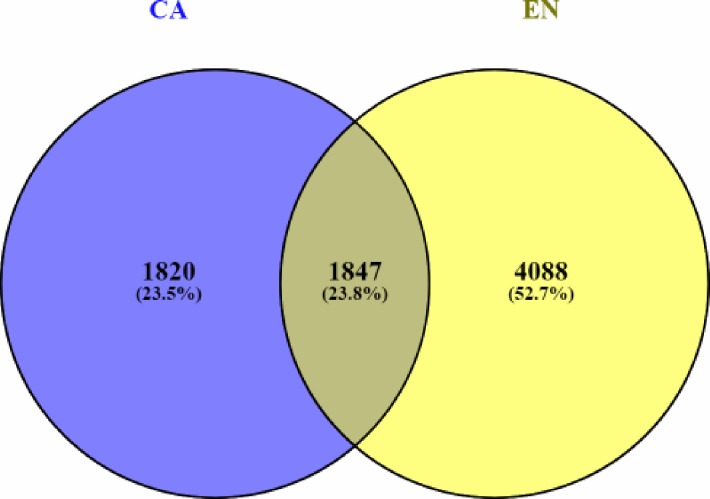
Venn diagram of differentially expressed genes.Graphical representation of the overlap of differentially expressed genes by group (FDR P-Value < 0.05). Includes genes which were differentially expressed in chorioallantois (CA), and endometrium (EN) across gestation.